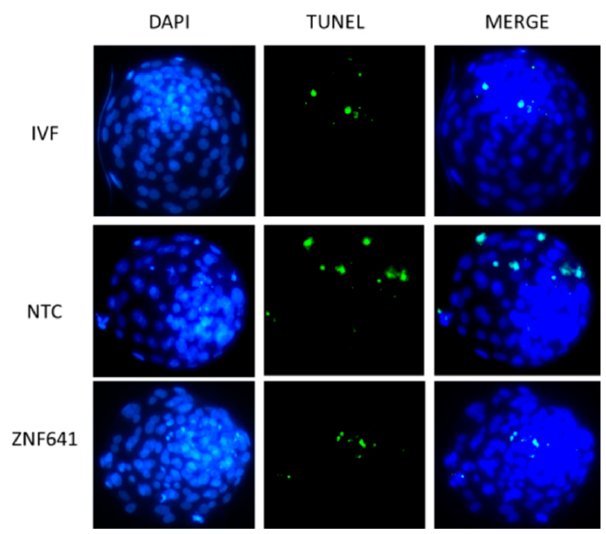
Figure 4. Effects of ZNF641 overexpression on the apoptosis in cloned blastocysts. Apoptosis in blastocysts was reported by TUNEL staining (green). DNA was stained by DAPI (blue). The total and apoptotic cell numbers in each individual blastocyst are indicated in Table 3. IVF, in vitro fertilized embryos; NTC, cloned embryos; ZNF641, the cloned embryos injected with ZNF641 mRNA.